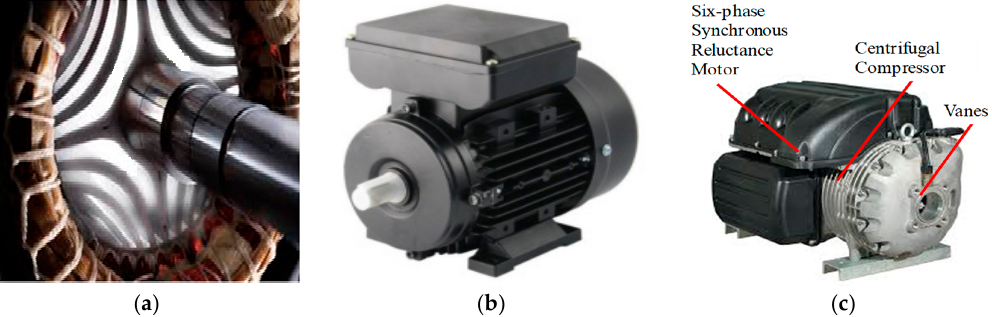
Figure 12. Completed photo pictures of six-phase synchronous reluctance motor: ( a ) stator, rotor and winding; ( b ) combination; ( c ) six-phase synchronous reluctance motor mounted to a centrifugal compressor.